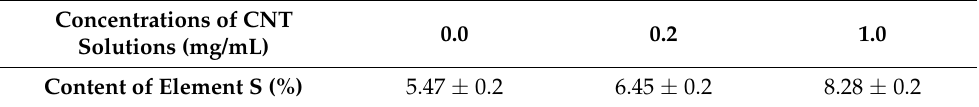
Figure 2. Sheet resistance and transmittance of films prepared under different conditions: ( a ) treatment method (CNT solution: 0.2 mg/mL); ( b ) spinning speed (CNT solution: 0.2 mg/mL); ( c ) concentration of CNT solution; ( d ) PEDOT: PSS hybrid with deionized water, methanol, and nitric acid (from left to right). Red circles in Figure 2d represent different aggregation states of PEDOT:PSS. The inset in Figure 2a shows a film falling off the substrate. Table 1. Content of S (wt %) in CNT/P-NTCFs prepared by CNT solutions of different concentrations.